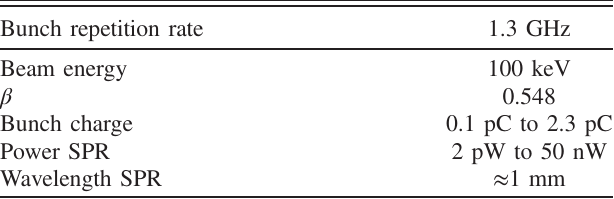
TABLE I. Parameters of the experiment.